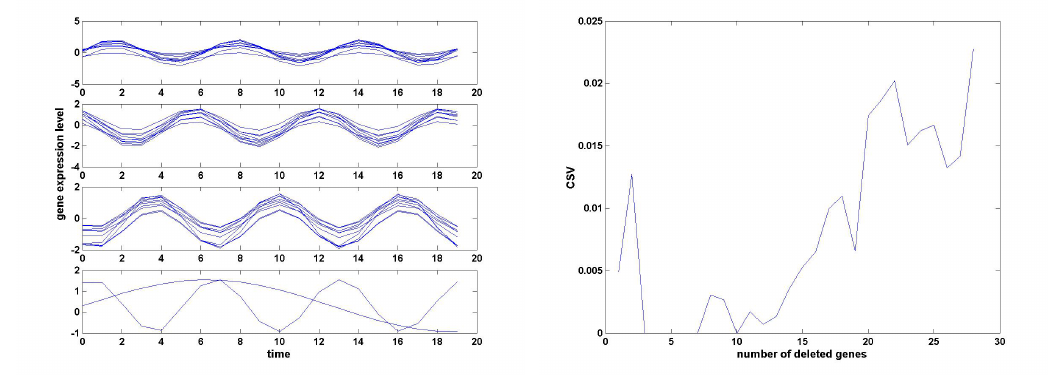
Figure 1: Artificial data